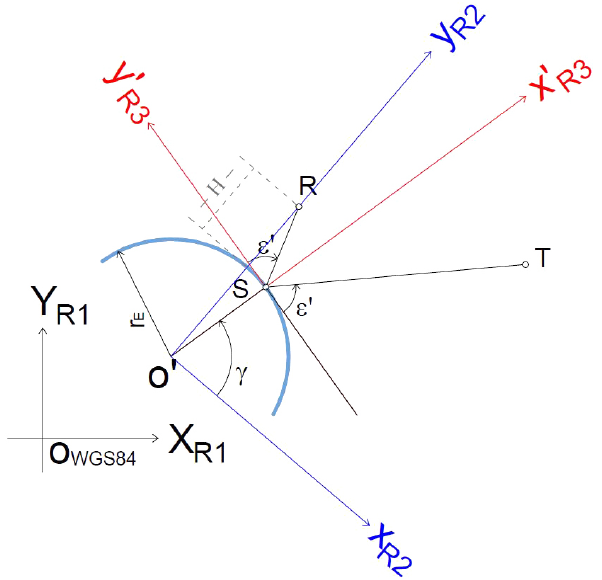
Figure 4. Local osculating sphere approximation: the three dif- ferent reference systems of coordinates. S : specular reflection point position. R : receiver position. T : transmitter/satellite posi- tion. ( 0 ,X,Y,Z) R 1 : WGS84 Cartesian system. ( 0 0 ,x,y) R 2 : local 2-D system, centred on the center of the osculating sphere, obtained by the rotation of the R 1 system around the Z axis, in such a way that x r equals 0. (S,x 0 ,y 0 ) R 3 : a local 2-D system, obtained by a rotation around the z axis and a r R translation of the R2 system in such a way that x 0 and the local vertical are colinear and the system origin coincides with the specular reflection point S